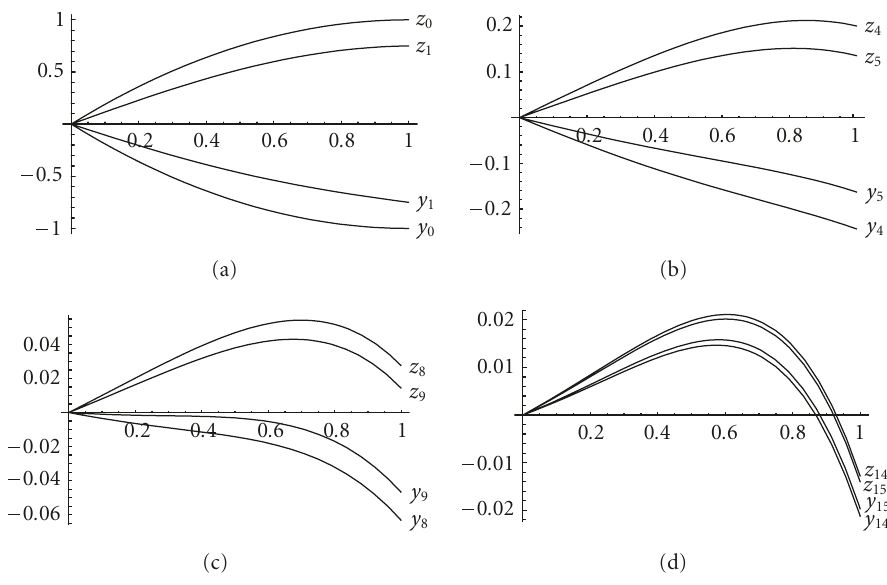
Figure 6.1. Chosen pairs of quasisolutions of problem